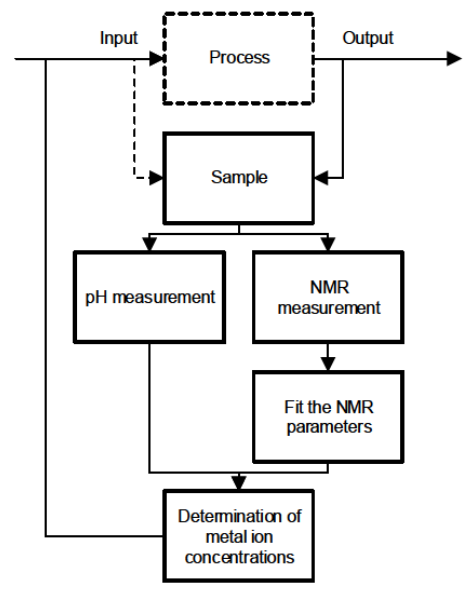
Figure 3: Flow chart of the measurement procedure.